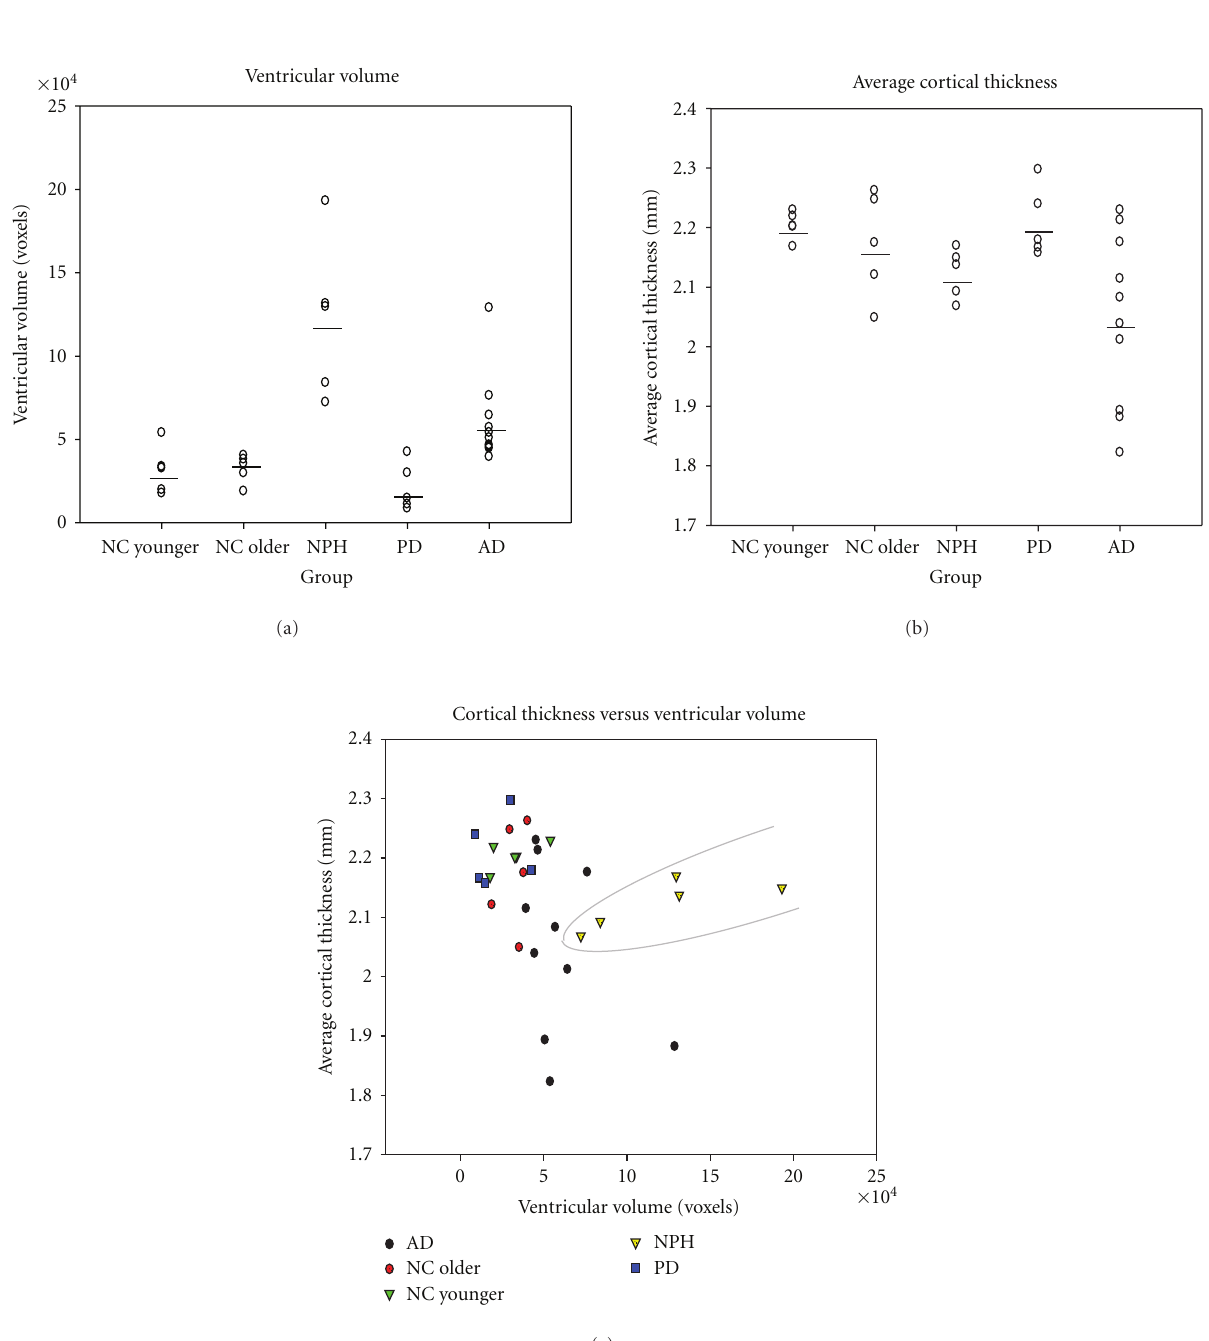
Figure 2: (a) Ventricular volume of NPH subjects overlaps that of AD patients. (b) Cortical thickness overlaps among all groups, with AD the best distinguished. (c) When ventricular volume and cortical thickness are both taken into account, NPH can be more clearly distinguished from the other